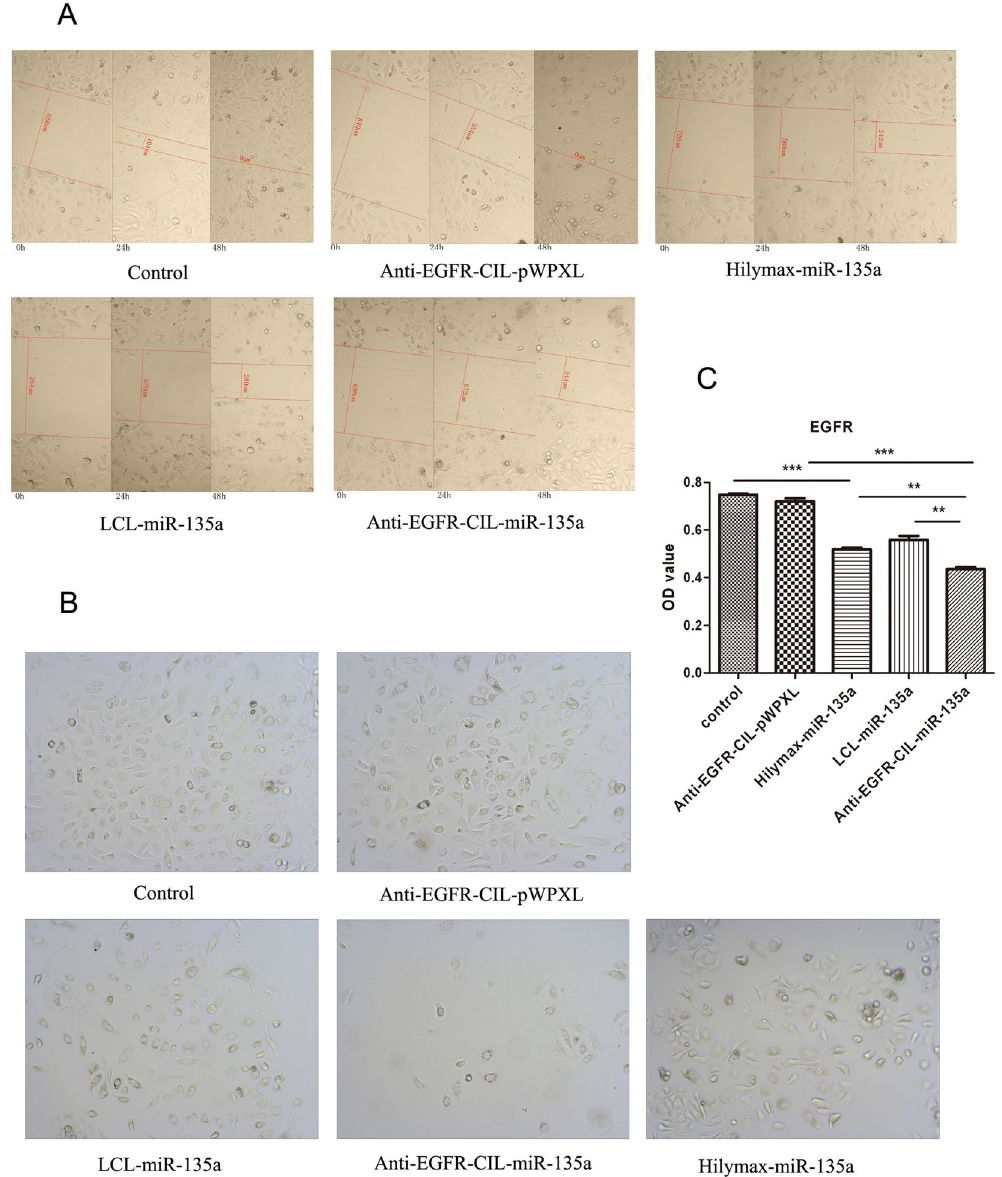
Figure 5. Scratch ( A ) and transwell ( B ) assays following Hilymax-miR-135a, LCL-miR-135a and Anti-EGFR- CIL-miR-135a treatment of GBC-SD cells at 0, 24 and 48 hours. ( C ) Invasive cell numbers of the Anti-EGFR- CIL-miR-135a group (LCL-miR-135a vs. Anti-EGFR-CIL-miR-135a; ** p <